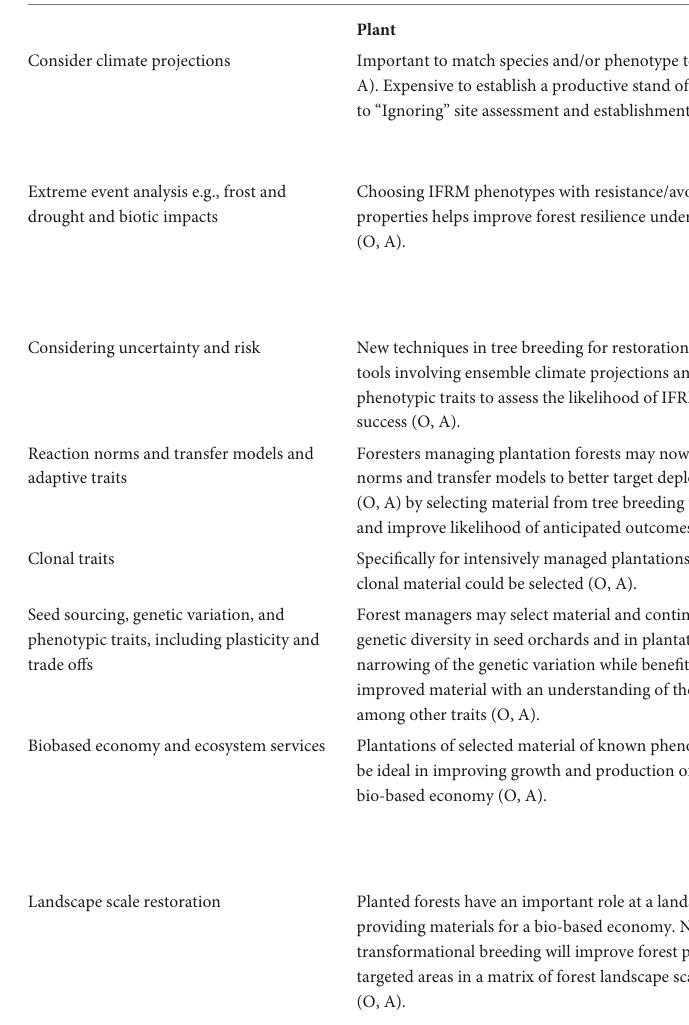
TABLE 1 Opportunities (O), advantages (A), disadvantages (D), and constraints (C) of new transformational approaches in tree breeding to “Plant, Rewild or Ignore” methods of forest restoration in which improved forest reproductive material (IFRM) and or material from natural regenerating forest material (NRFM) might be managed, or no management natural colonisation (NMNC) is considered